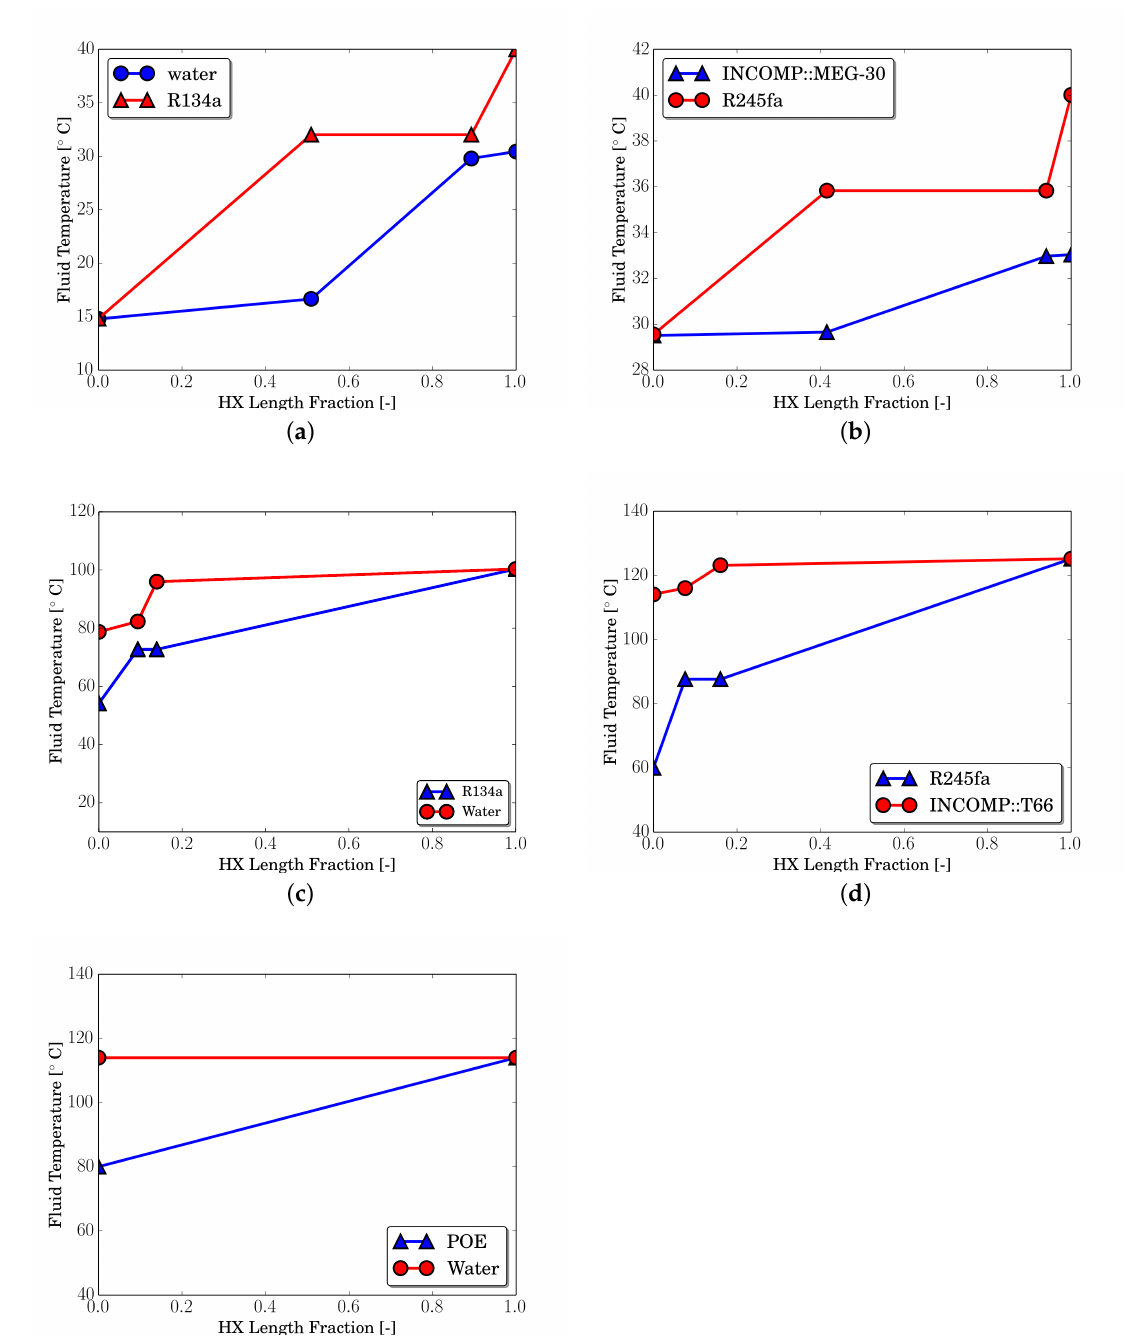
Figure 3. Examples of temperature profiles along the length of the Plate Heat Exchangers (PHEXs) for different types of hot stream and cold stream fluids. The details of the PHEXs and the ORC setups in which they are installed are described in Section 4.1. ( a ) ORC at Purdue University (PU): Condenser; ( b ) ORC at Ghent University (UGent): Condenser; ( c ) ORC at PU: Evaporator; ( d ) ORC at UGent: Evaporator; ( e ) ORC at PU: Lubricant oil